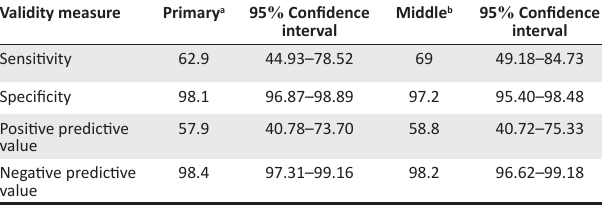
TABLE 3: Screening efficacy of the teachers: validity by age of